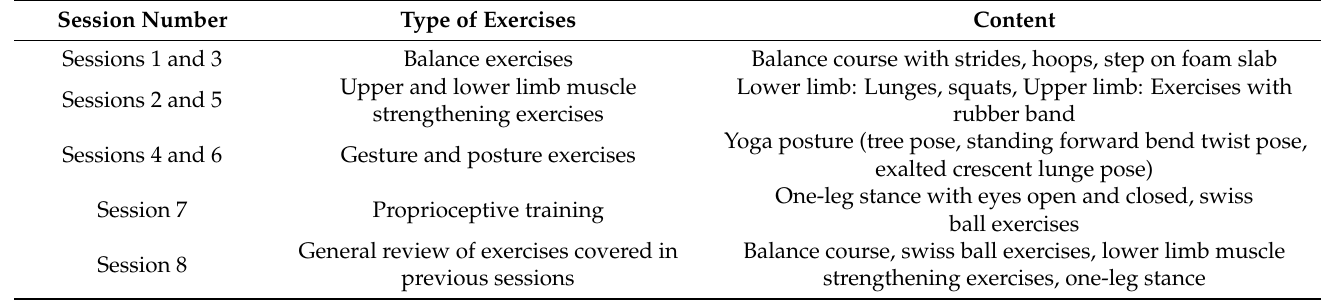
Table 1. Description of the multicomponent physical exercise